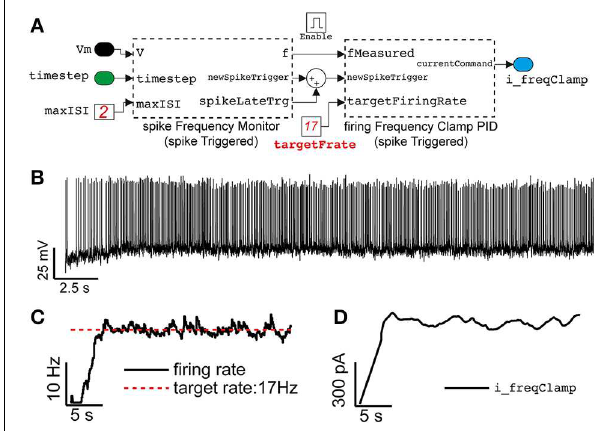
FIGURE 7 | Close-loop control of the neuronal mean firing rate, in the same model of Figures 4, 5. Adopting the approach outlined in Miranda-Dominguez et al. (2010), Linaro et al. (2014), an elementary Proportional-Integrative-Derivative (PID) controller (A) is demonstrated to automatically tune the value of the external current input current (see Figure 4A ) to (initially) constrain the average neuronal firing frequency to a desired value (B,C) . Despite the irregular firing (recreated) regime (i.e., R e = 7000 Hz, R i = 2149 Hz), the PID controller adapts in real-time I ext (D) on the basis of a feedback reaction (i.e., P = 0 .0045, I = 0 .0023, D = 0 , see the